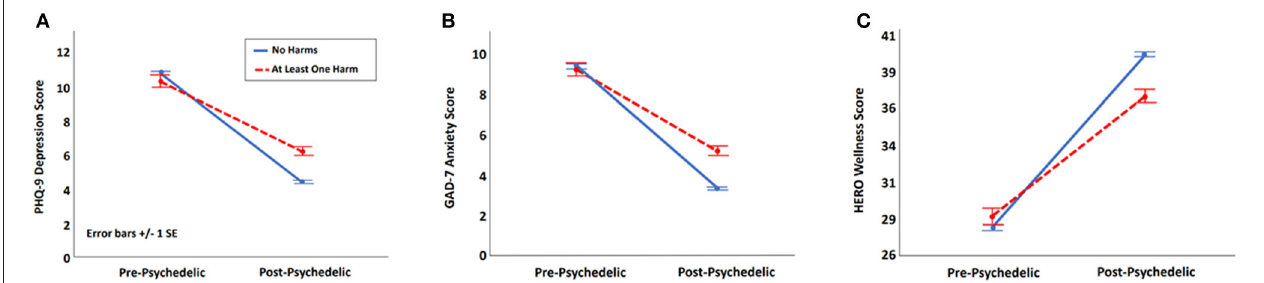
FIGURE 1 | Effect of psychedelic exposure in participants with and without reported harms for use. (A) Effect of harms on depressive symptoms measured with the 9-items Patient Health Questionnaire (PHQ-9). (B) Effect of harms on anxious symptoms measured with the 7-item Generalized Anxiety Scale (GAD-7). (C) Effect of harms on wellness measured with the Hero Wellness